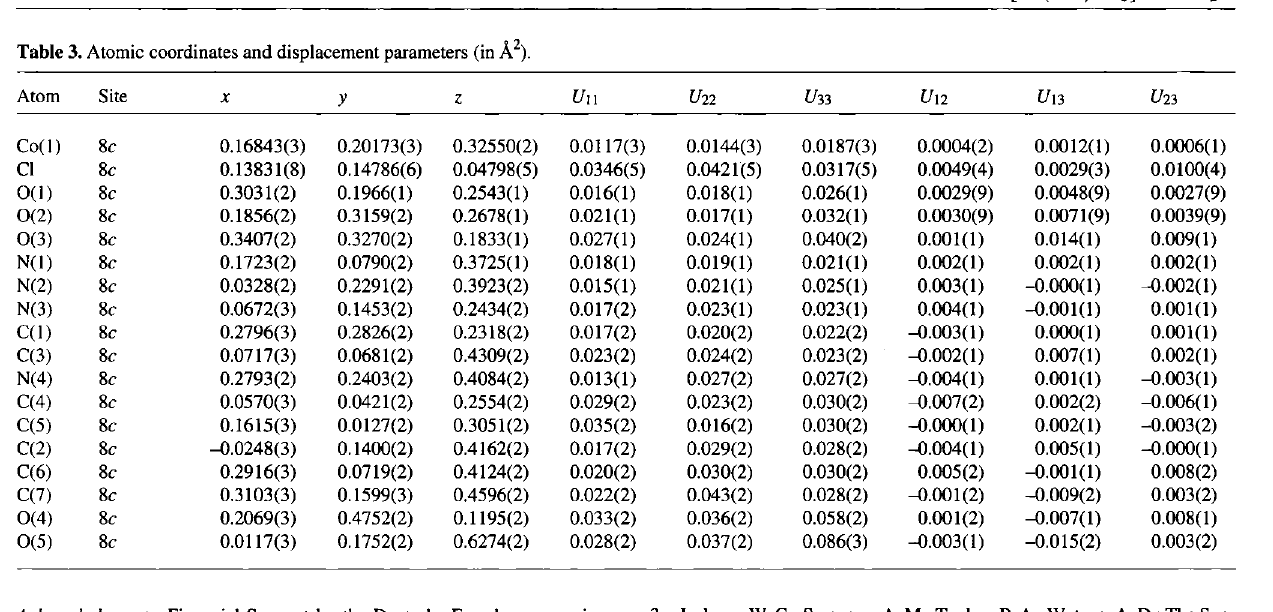
Table 3. Atomic coordinates and displacement parameters (in Â 2